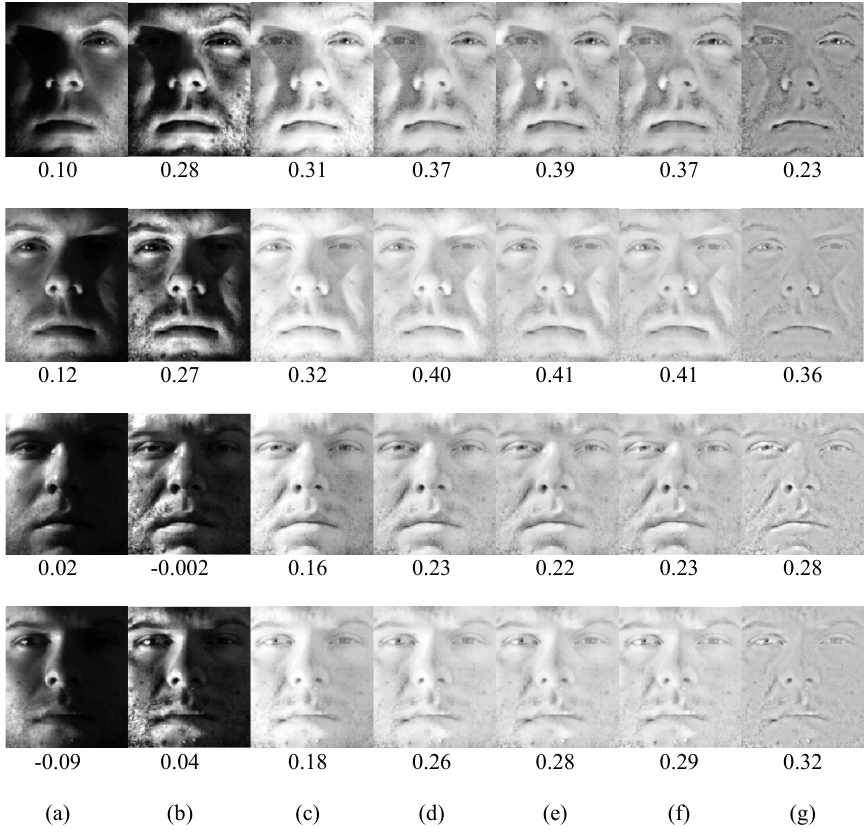
Figure 3. Sample images from extended Yale B face database (a) original database images (b) after processing by AHE (c) after processing by AHELT (d) after processing by proposed method with α = -7 and β = 21 (e) after processing by proposed method with α = -15 and β = 55 (f) after processing by proposed method with α = -30 and β = 105 (g) after processing by proposed method with α = -210 and β =